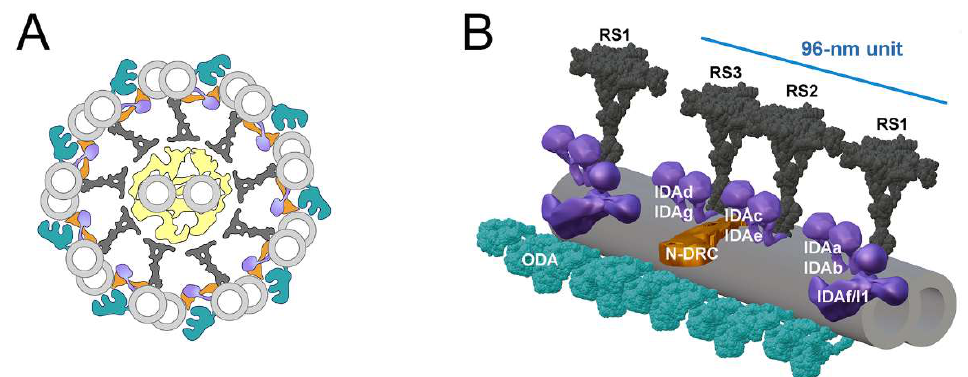
Figure 1. Schematic representation of the motile cilium structure. ( A ) Cilium cross-section. Two central microtubules (grey), together with associated complexes, a connecting bridge and projections (yellow), form a central apparatus. Main outer doublets (grey) complexes: outer dynein arms (ODAs, greenish), inner dynein arms (IDAs, purple), radial spokes (RSs, dark grey), nexin-dynein regulatory complex (N-DRC, orange); ( B ) Fragment of the outer doublet showing organization of ciliary complexes within a 96-nm outer doublet axonemal unit [9,10]. ODA (7K5B, PDB DOI: 10.2210/pdb7K5B/pdb [11]) and RS (7JTK, PDB DOI: 10.2210/pdb7JTK/pdb [12]) structures were obtained from a Protein Data Bank (https://www.rcsb.org (accessed on 20 November 2022)). Other ciliary complexes were designed using Adobe Photoshop and Blender programs.